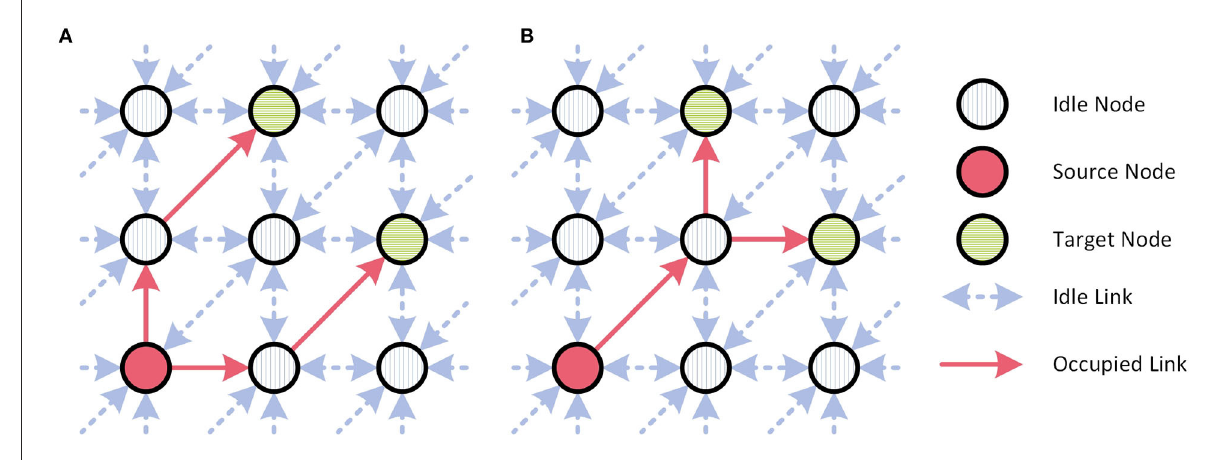
FIGURE3 The difference in network load between two possible shortest routes to reach all destinations with an MC packet, (A) 4 different links used and (B) 3 different links